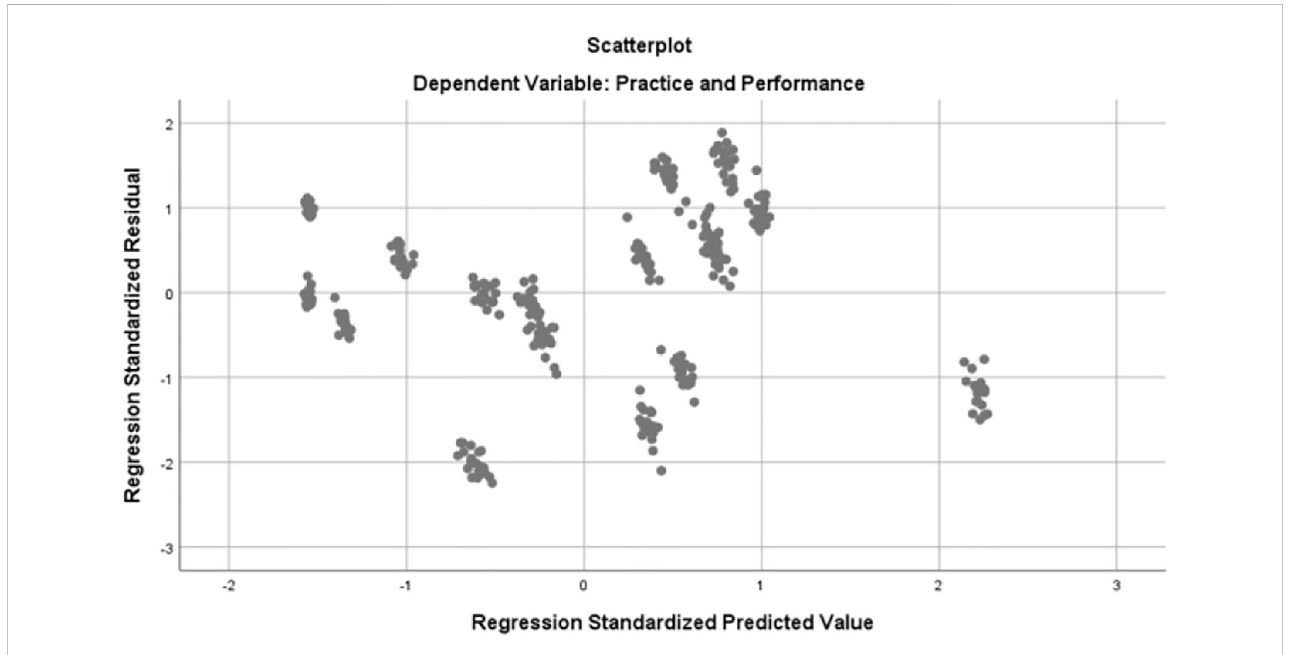
FIGURE 10 Regression ’ s scatter plot water sector governance